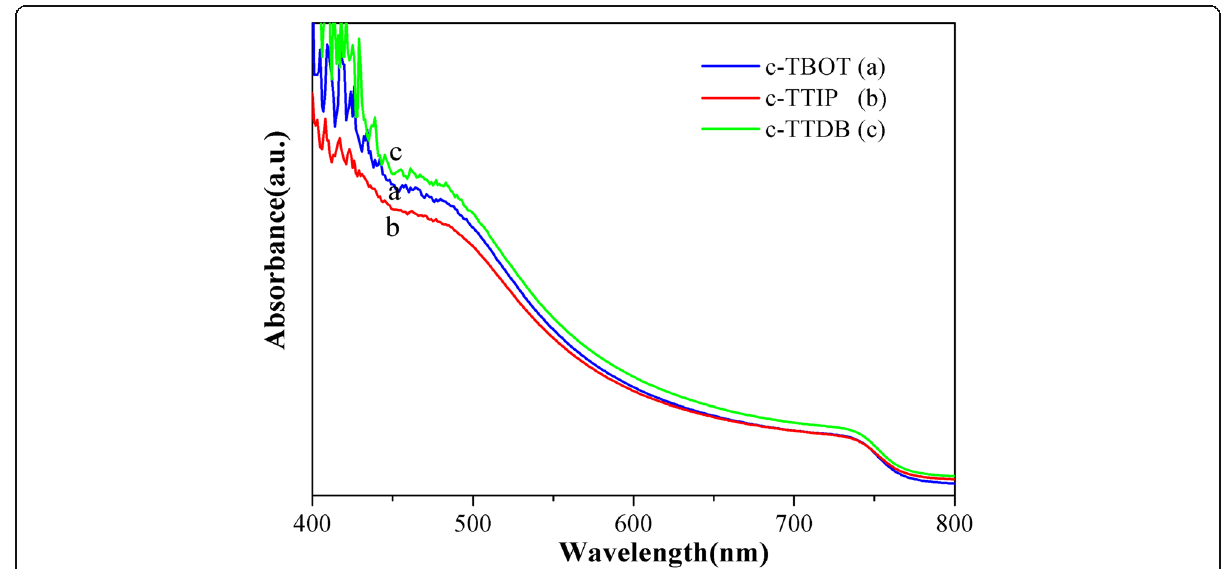
Fig. 5 UV-vis absorption spectra of perovskite films based on different compact layers